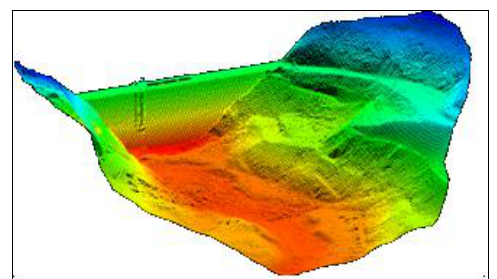
Figure 9. Assembly of point clouds on Cyclone software